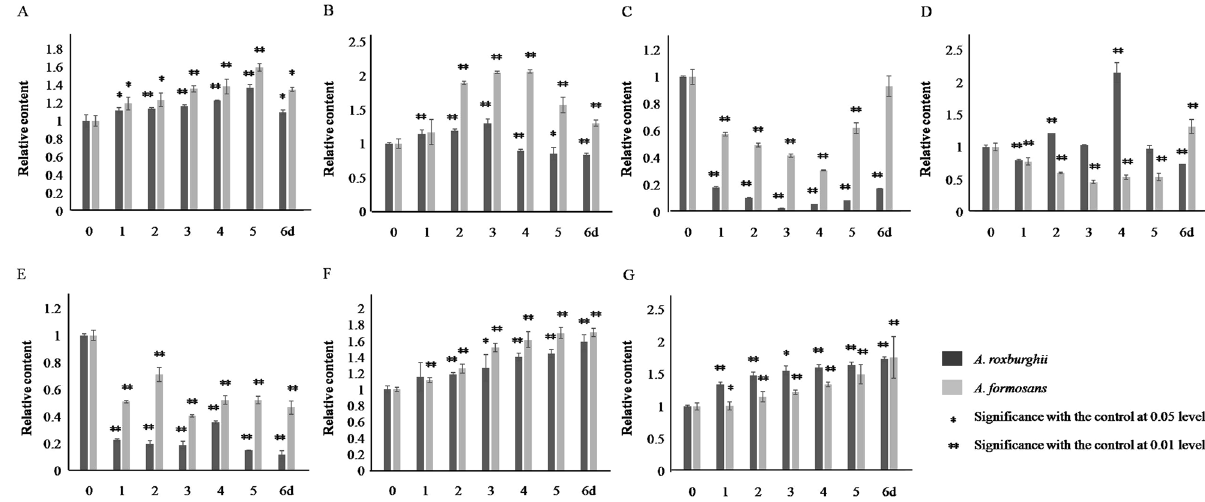
Figure 6. Content of total flavonoids, flavonols, anthocyanidin, and MDA, and FRSA in A. roxburghii and A. formosanus under Phe induction. The asterisk ( * ) and double asterisk ( ** ) stand for significance with the control at 0.05 and 0.01 levels, respectively. ( A ) flavonoids content. ( B ) Free radical scavenging rate. ( C ) rutin content. ( D ) quercetin content. ( E ) kaempferol content. ( F ) Anthocyanidin content. ( G ) MDA content.